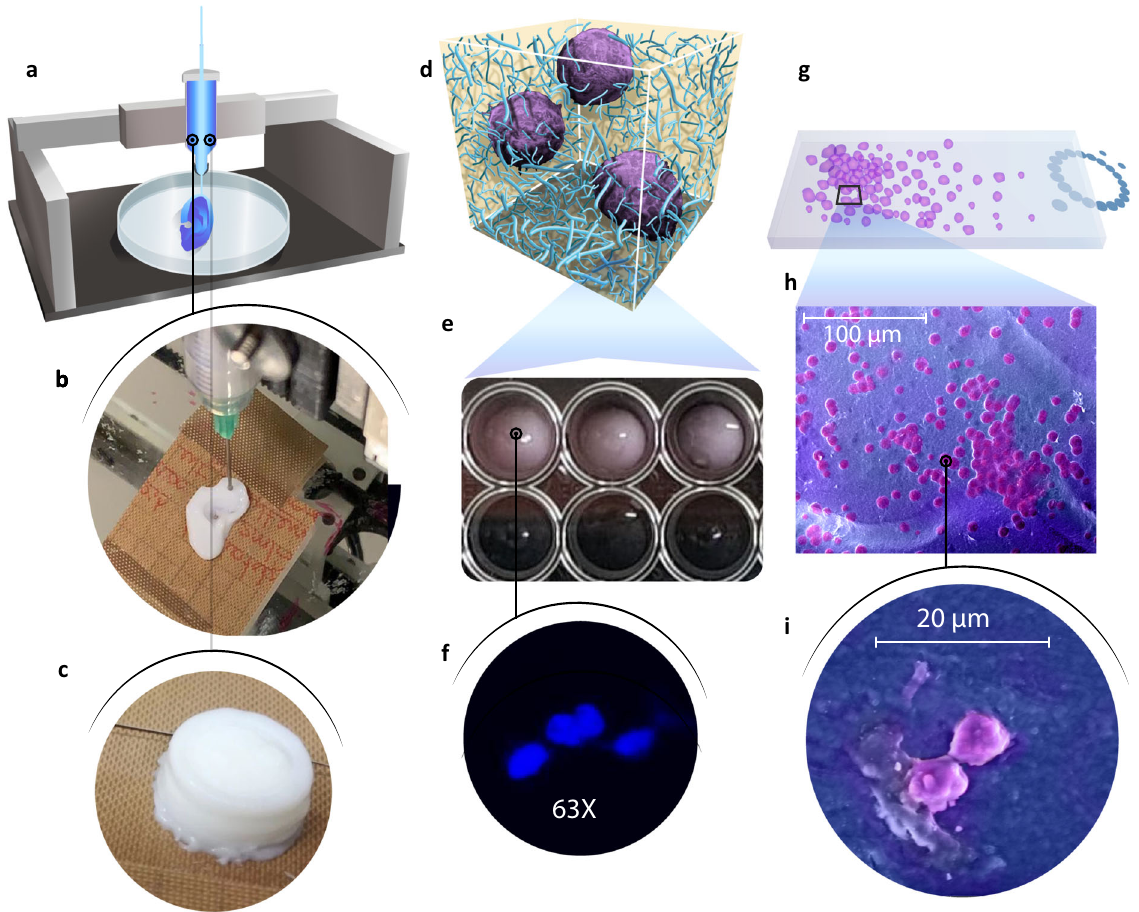
Fig. 4 Cell proliferation on EnCNC 2D and 3D cultures. a Schematic representation of 3D printer using EnCNC suspension as ink. b Image of a human ear-like piece of ~1 cm 3 printed with 10 wt% EnCNC suspension. c Scaffold of 1.5 cm 3 made with 10 wt% EnCNC suspension for 3D cell culture. d Representation of cells embedded on EnCNC matrix. e Portion of a 24-well plate containing a 3D-printed scaffold of EnCNC bioink similar to the one in c and HEK293 in cell culture medium. f Confocal microscopy image at ×63 of HEK293T-stained nuclei with DAPI. Cells proliferated embedded on EnCNC matrix after 3 days of culture. g Schematic representation of 2D EnCNC for 2D cell culture. h SEM images of HEK293T living over EnCNC fi lm after 3 days of culture. Cells were colored in pink and EnCNC fi lm in blue. i Close-up image of two HEK293 cells dividing over EnCNC fi